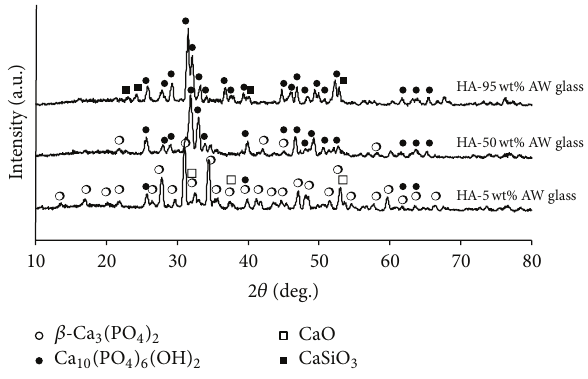
Figure 4: XRD patterns of HA-AW composites sintered at 1200 ∘ C for 2